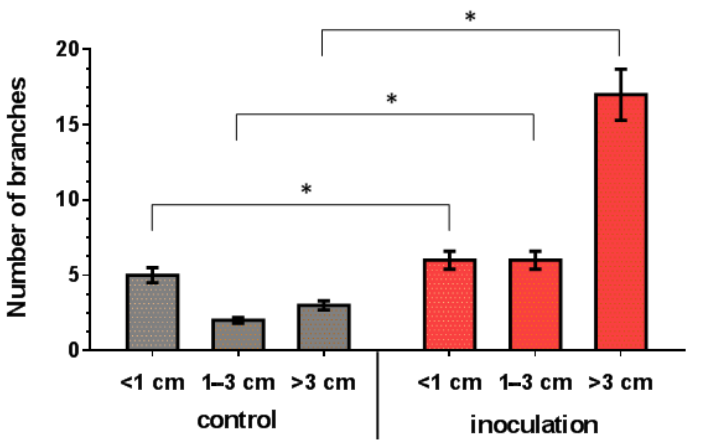
Figure 7. Response of length and number of V. macrocarpon branches to 5 months of co-cultivation with P. fortinii DSE2 isolate. * indicates statistically significant differences after Mann–Whitney correction was applied, p < 0.05.